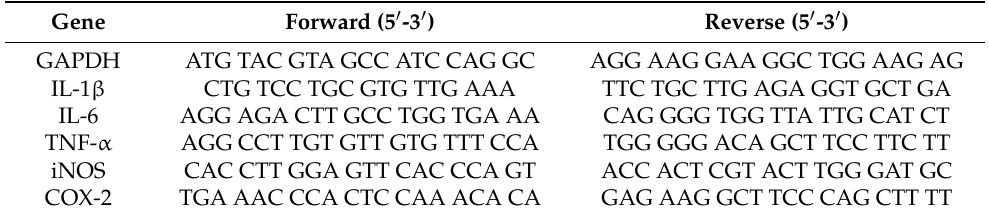
Table 1. Primer sequences of the tested genes.